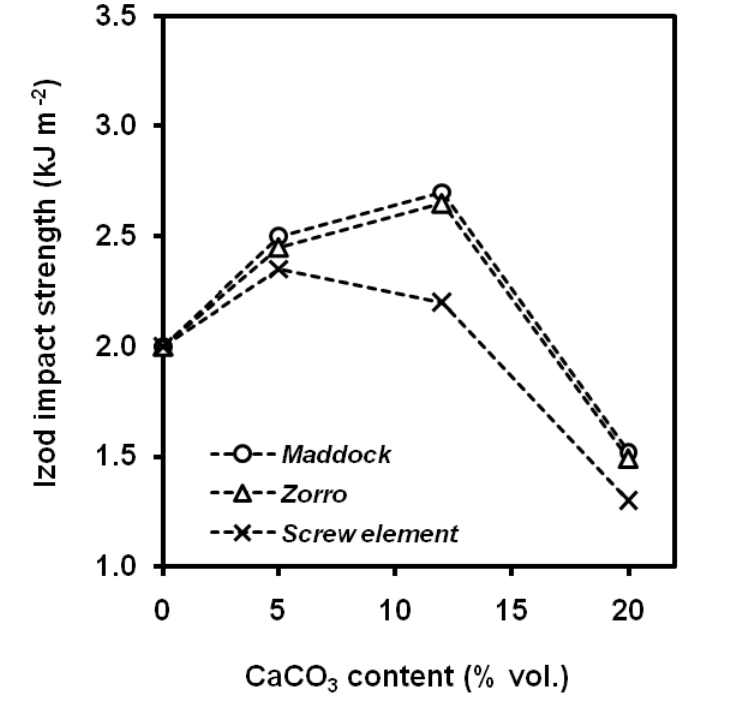
Figure 24. Notched Izod impact strength evolution with silane-treated CaCO several screw configurations (adapted from